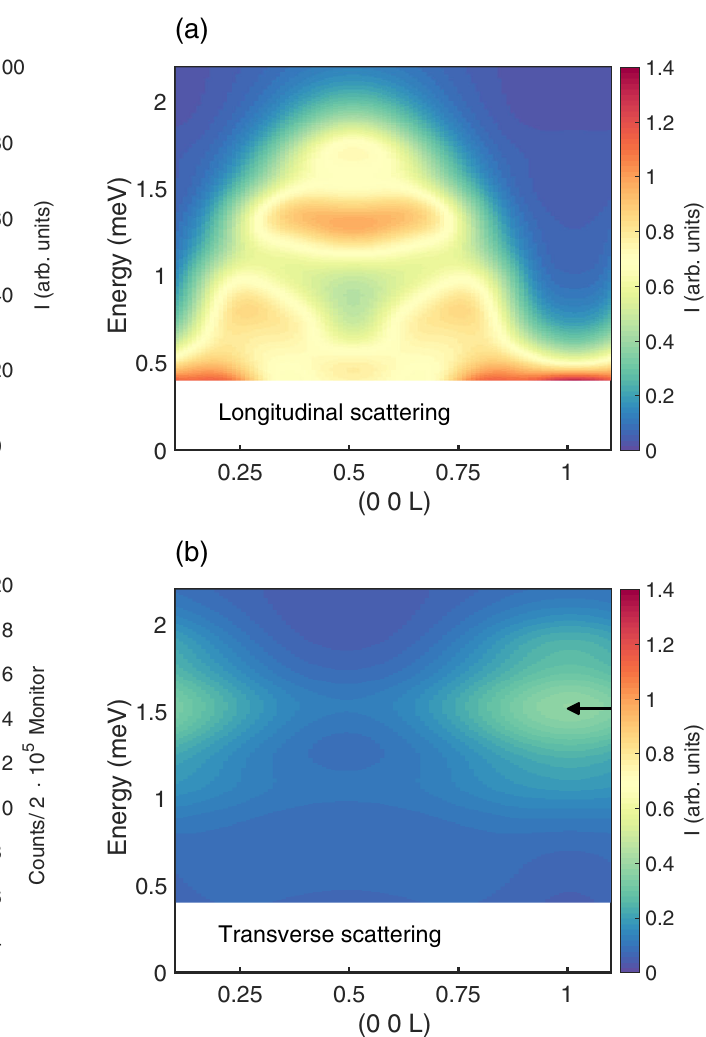
Fig. 2 The zero- fi eld scattering continua. a Numerical approximation of S ( Q , ω ) using the same parameters as in Fig. 1. Note that the checkerboard pattern within the continuum is due to fi nite size effects in the numerical calculation. Equation (5) is superimposed as a black solid line and equation (6) as a black dashed line. b Inelastic neutron scattering data at zero fi eld and T = 22 K obtained using MACS.